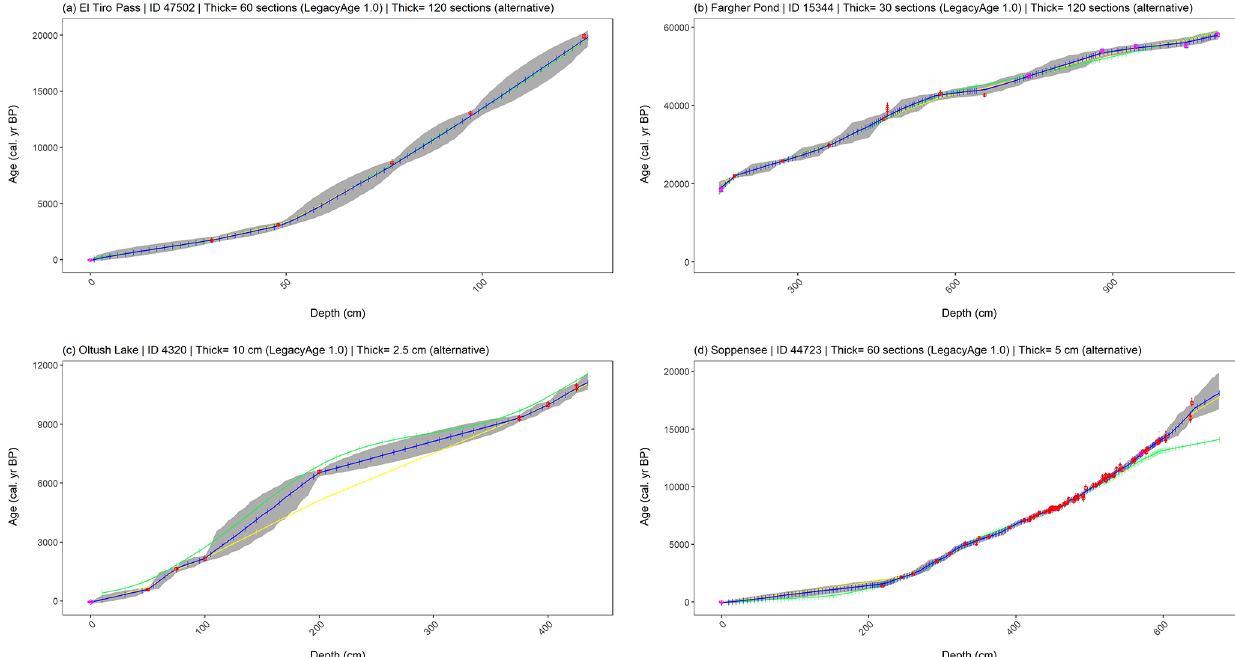
Figure 7. Comparison of LegacyAge 1.0 chronologies with the original ones. Green line: original chronology. Blue line: LegacyAge 1.0 chronology. Yellow line: alternative newly generated but rejected chronology. Red: date in chronology metadata. Pink: date from prior information. Grey shading: age uncertainties (95% confidence